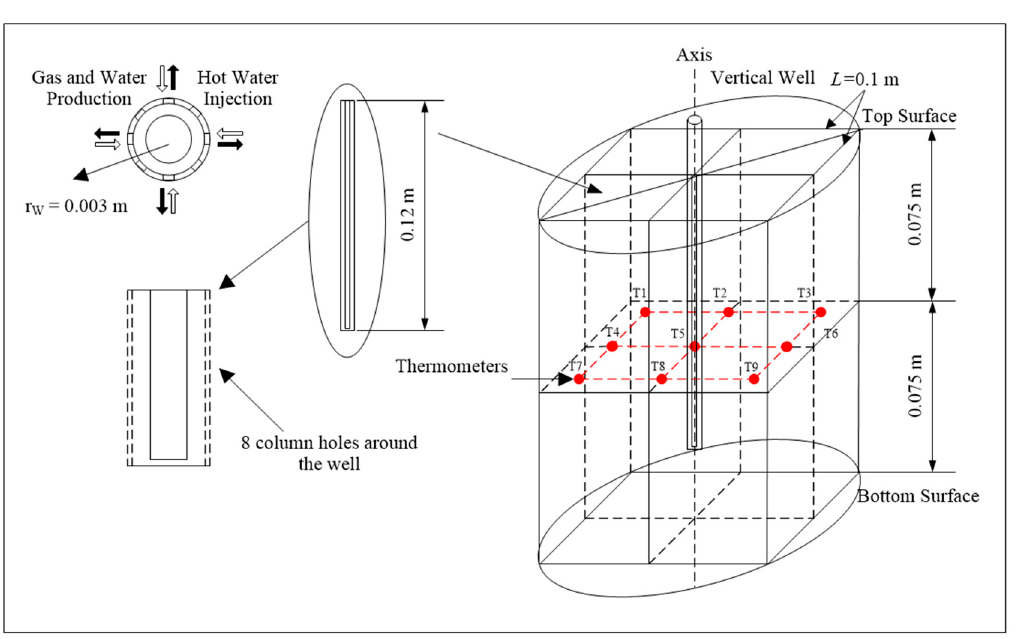
Figure 2. Reactor internal structure and well design.